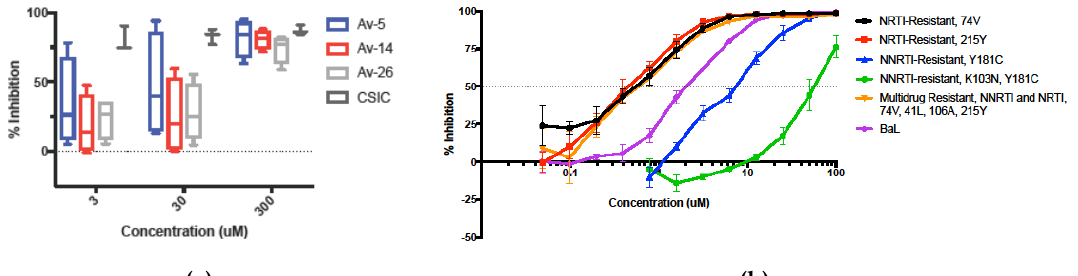
Figure 3. Reverse Transcriptase Inhibition Activity of Avirulin Lead Compounds. For determination of the viral target of Avirulins, commercially available assays for detection of HIV-1 integrase, protease, and reverse transcriptase (RT)-inhibition, were performed with lead compounds Av-5, Av-14, and Av-26. Avirulins showed no HIV-1 integrase inhibition or protease inhibition, but dose dependent inhibition of HIV-1 RT was found using a commercially available RT-inhibition assay (Roche) ( a ). The nonnucleoside reverse transcriptase inhibitor (NNRTI), 5-chloro-3-(phenylsulfonyl)indole-2-carboxamide (CSIC), was used as a positive control, and RT-inhibition was calculated by comparison with DMSO vehicle equivalent, with experiments performed in duplicate, n = 4, error = SEM. ( b ) To evaluate Avirulin antiviral activity in drug resistant strains of HIV-1, Av-5, the lead compound with greatest RT-inhibition and lowest IC 50 , was used to inhibit common RT-inhibitor resistant strains, two nucleoside RT-inhibitors, two nonnucleoside reverse transcriptase inhibitors, and one multidrug resistant strain, using a luciferase TZM-bl reporter assay. Inhibition was calculated by comparison to DMSO vehicle control. n = 4, error = SEM. Resistant strains were clinical isolates or inhibitor desensitized laboratory strains acquired through the NIH AIDS Reagent Program and expanded in PM1 cell culture. PM1 cell supernatants were used for infections.